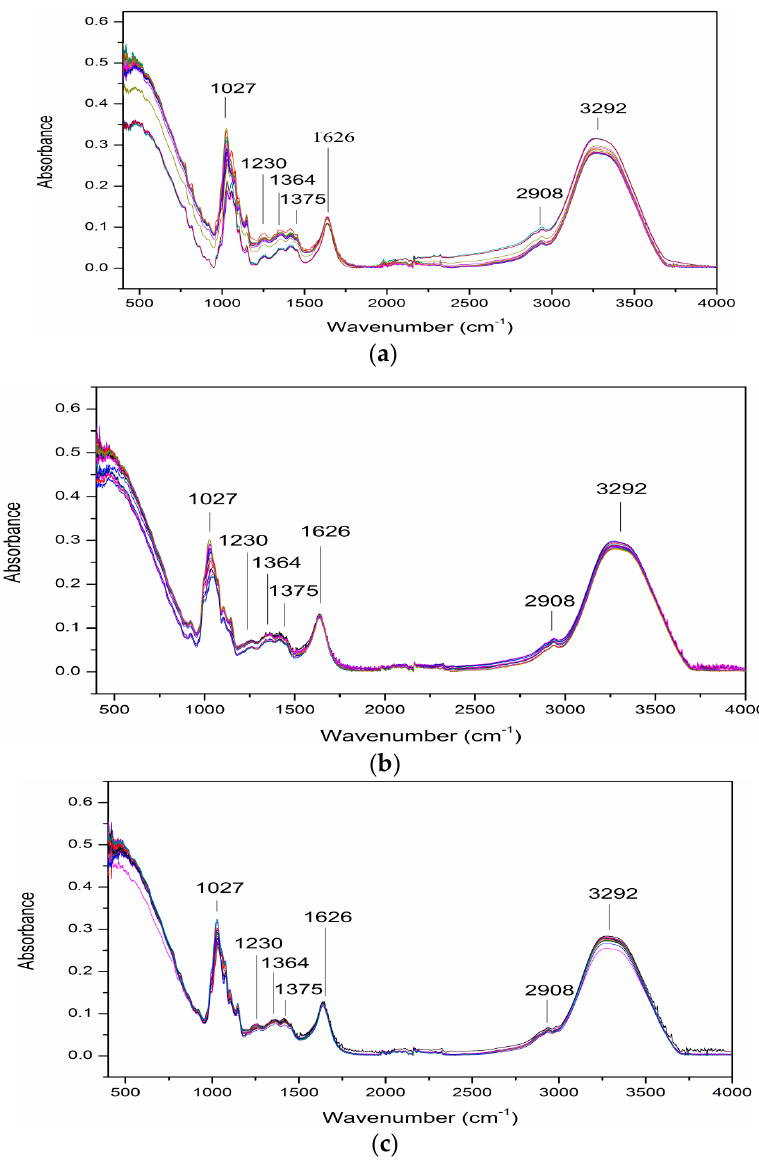
Figure 2. FTIR spectra of adulterated grape ( a ), carob ( b ) and mulberry ( c ) pekmez samples.